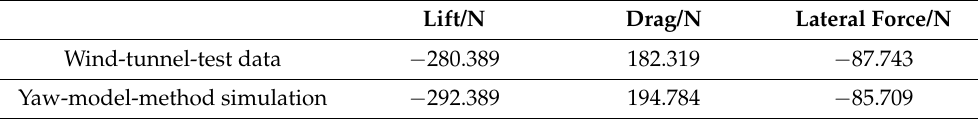
Table 3. Aerodynamic characteristics of FSAE racing car under the action of 10 ◦ crosswind